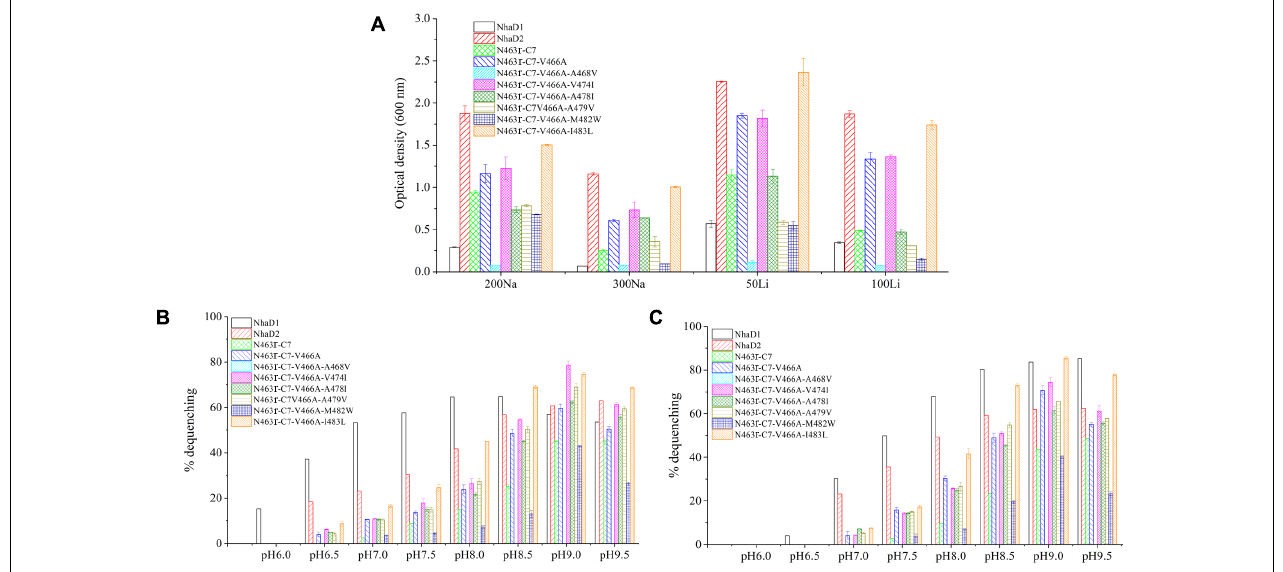
FIGURE 6 | Growth and antiport activities of N463r-C7 mutants in TM XIII. (A) Growth of mutants in the LBK medium containing indicated concentrations of NaCl or LiCl. (B) Fluorescence-based assays of mutants which initiated by 10 mM Na + and measured at different pH values. (C) Fluorescence-based assays of mutants which initiated by 10 mM Li + and measured at different pH values.